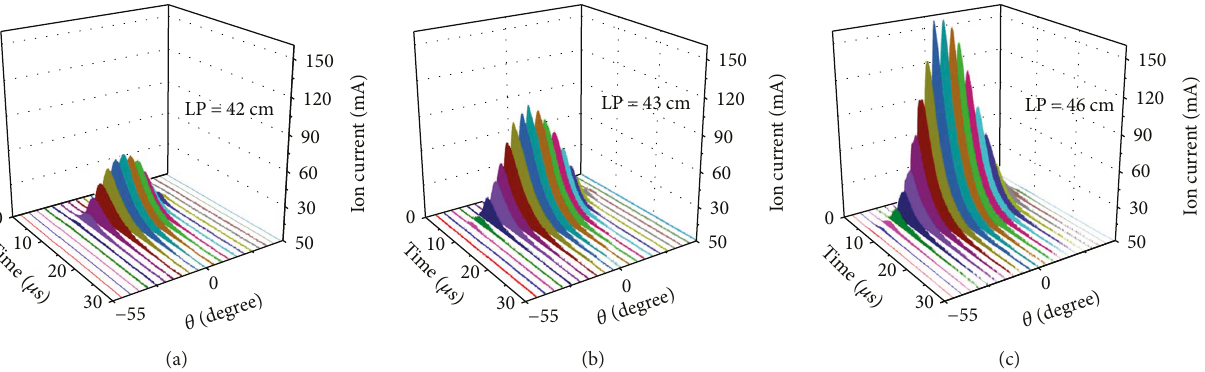
Figure 4: Temporal traces of FC-recoded signals in various angular positions and di ff erent laser beam focusing LP =42 cm (a), LP =43 cm (b), and LP =46 cm (c).